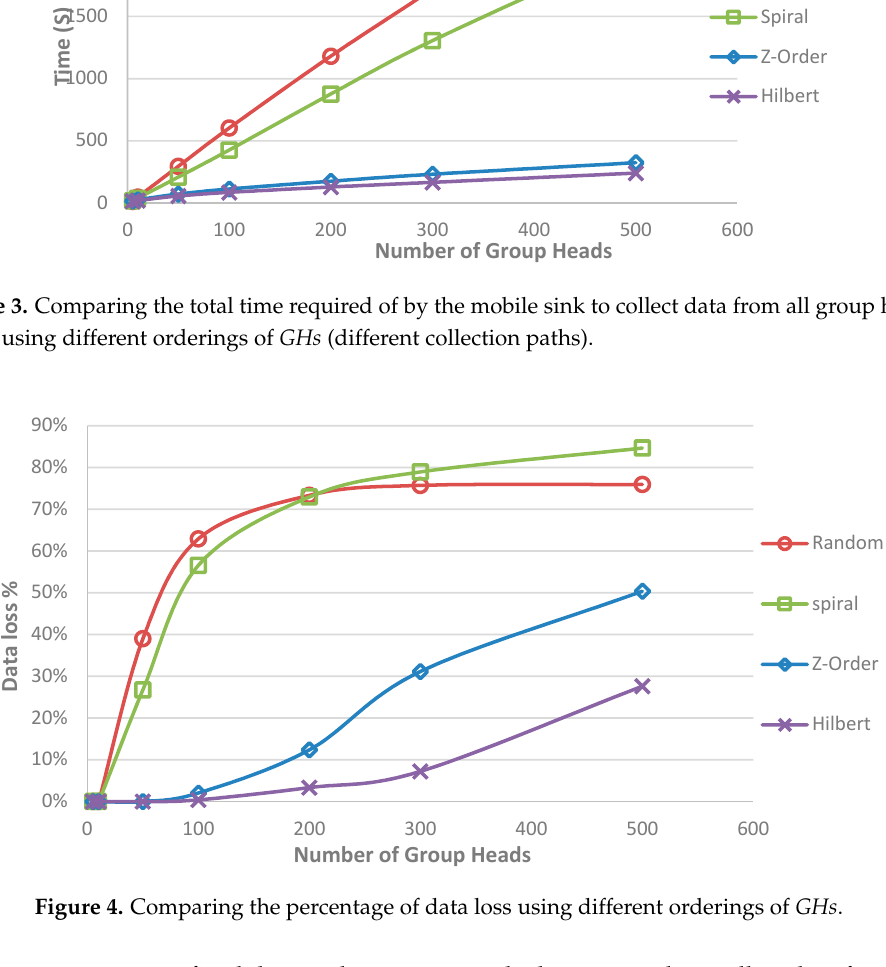
Figure 3. Comparing the total time required of by the mobile sink to collect data from all group heads ( GHs ) using different orderings of GHs (different collection paths).